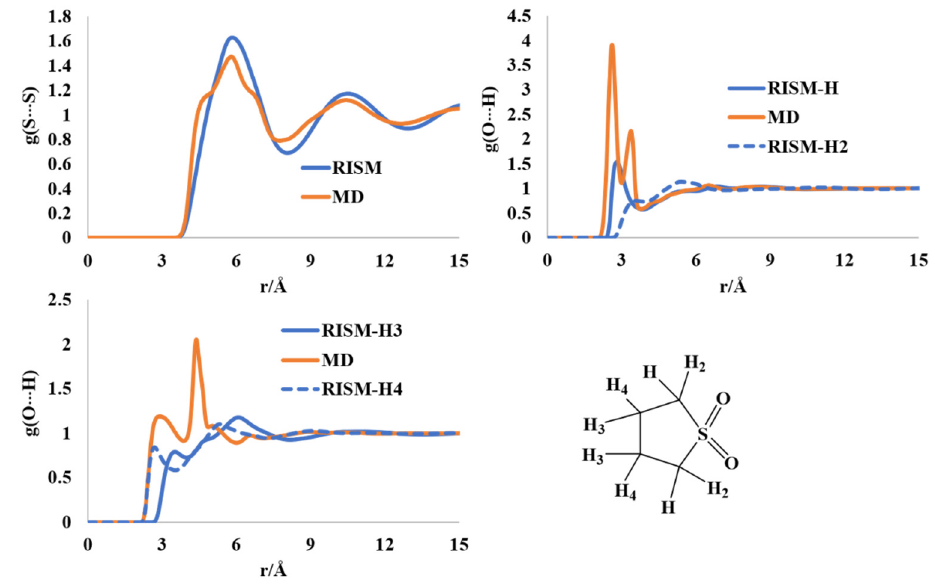
Figure 8. RISM- and MD-computed distribution functions for liquid sulfolane.